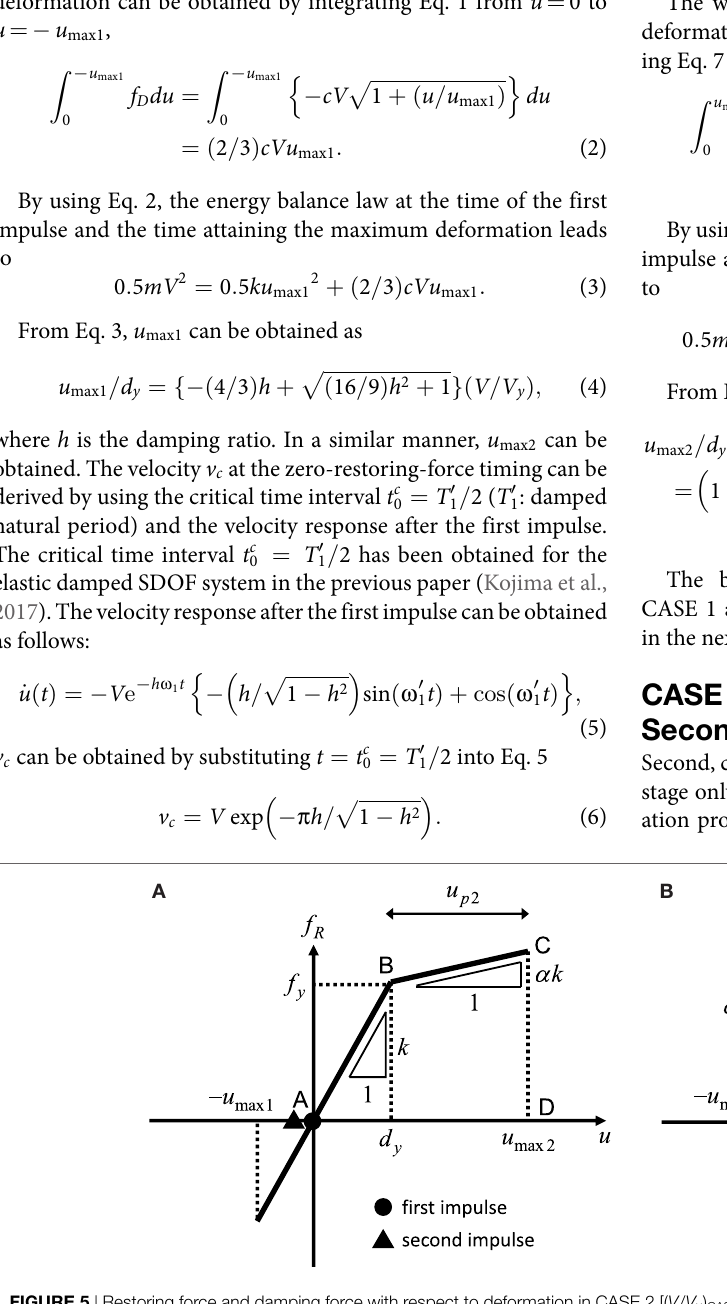
Frontiers in Built Environment |